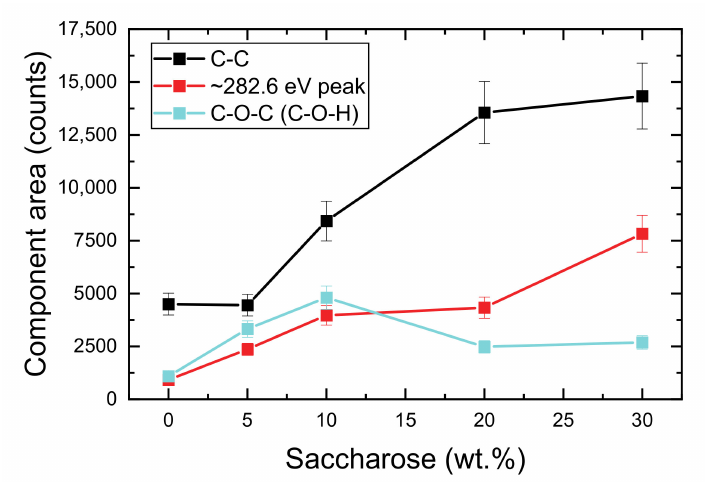
Figure 3. Areas of the C-O-C (C-O-H), C-C and ~282.6 eV components, obtained from the carbon C1s peak fit, presented as a function of the saccharose solution concentration (0—without modification, 5 wt%, 10 wt%, 20 wt%, 30